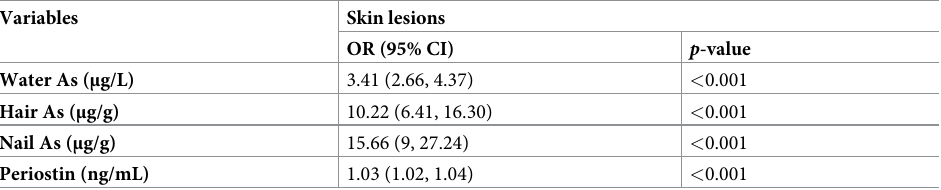
many individuals were found to have subclinical effects (without visible skin lesions) [1, 62, 63]. In our study, it is likely that many participants without apparent skin lesions in the high- exposure areas were subclinical patients. Therefore, we further divided the participants Table 2. Association of arsenic exposure and serum periostin levels with the risk of skin